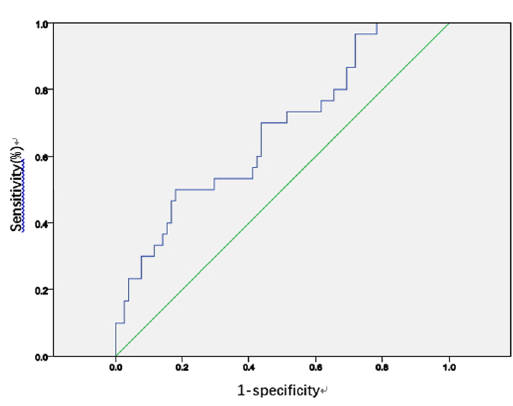
Figure 2. ROC curve of the